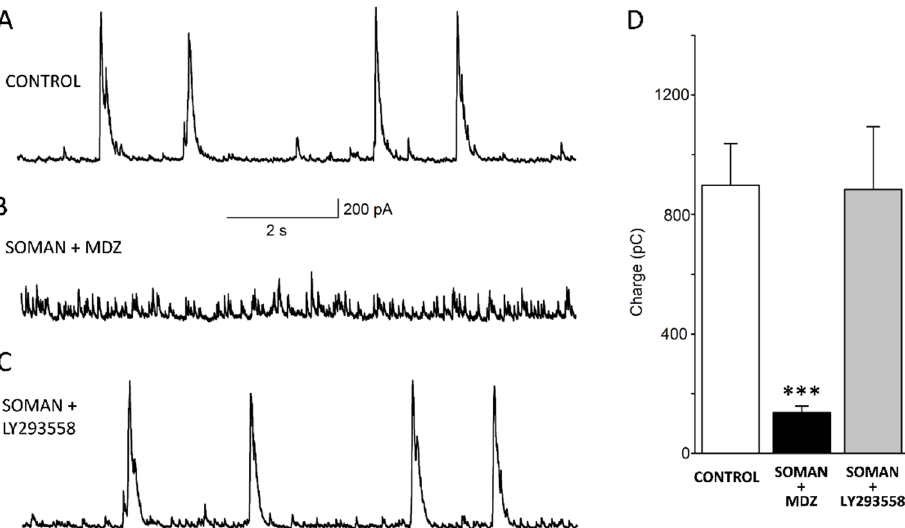
Figure 4. Thirty days after soman exposure, spontaneous inhibitory activity was reduced in the BLA of the MDZ-treated group but not the LY293558-treated group. Representative GABA A receptor- mediated sIPSC current traces recorded from BLA principal neurons from a control rat ( A ) and from soman-exposed rats treated with MDZ ( B ) or LY293558 ( C ). Recordings were obtained at +30 mV holding potential; ( D ) Group data of charge transferred by sIPSCs, during a 10 s time window. *** p < 0.001 when inhibitory activity of neurons from the MDZ-treated group ( n = 14) is compared with the inhibitory activity in either the control ( n = 14) or the LY293558-treated group ( n = 8; Welch’s ANOVA followed by Games–Howell post hoc test).